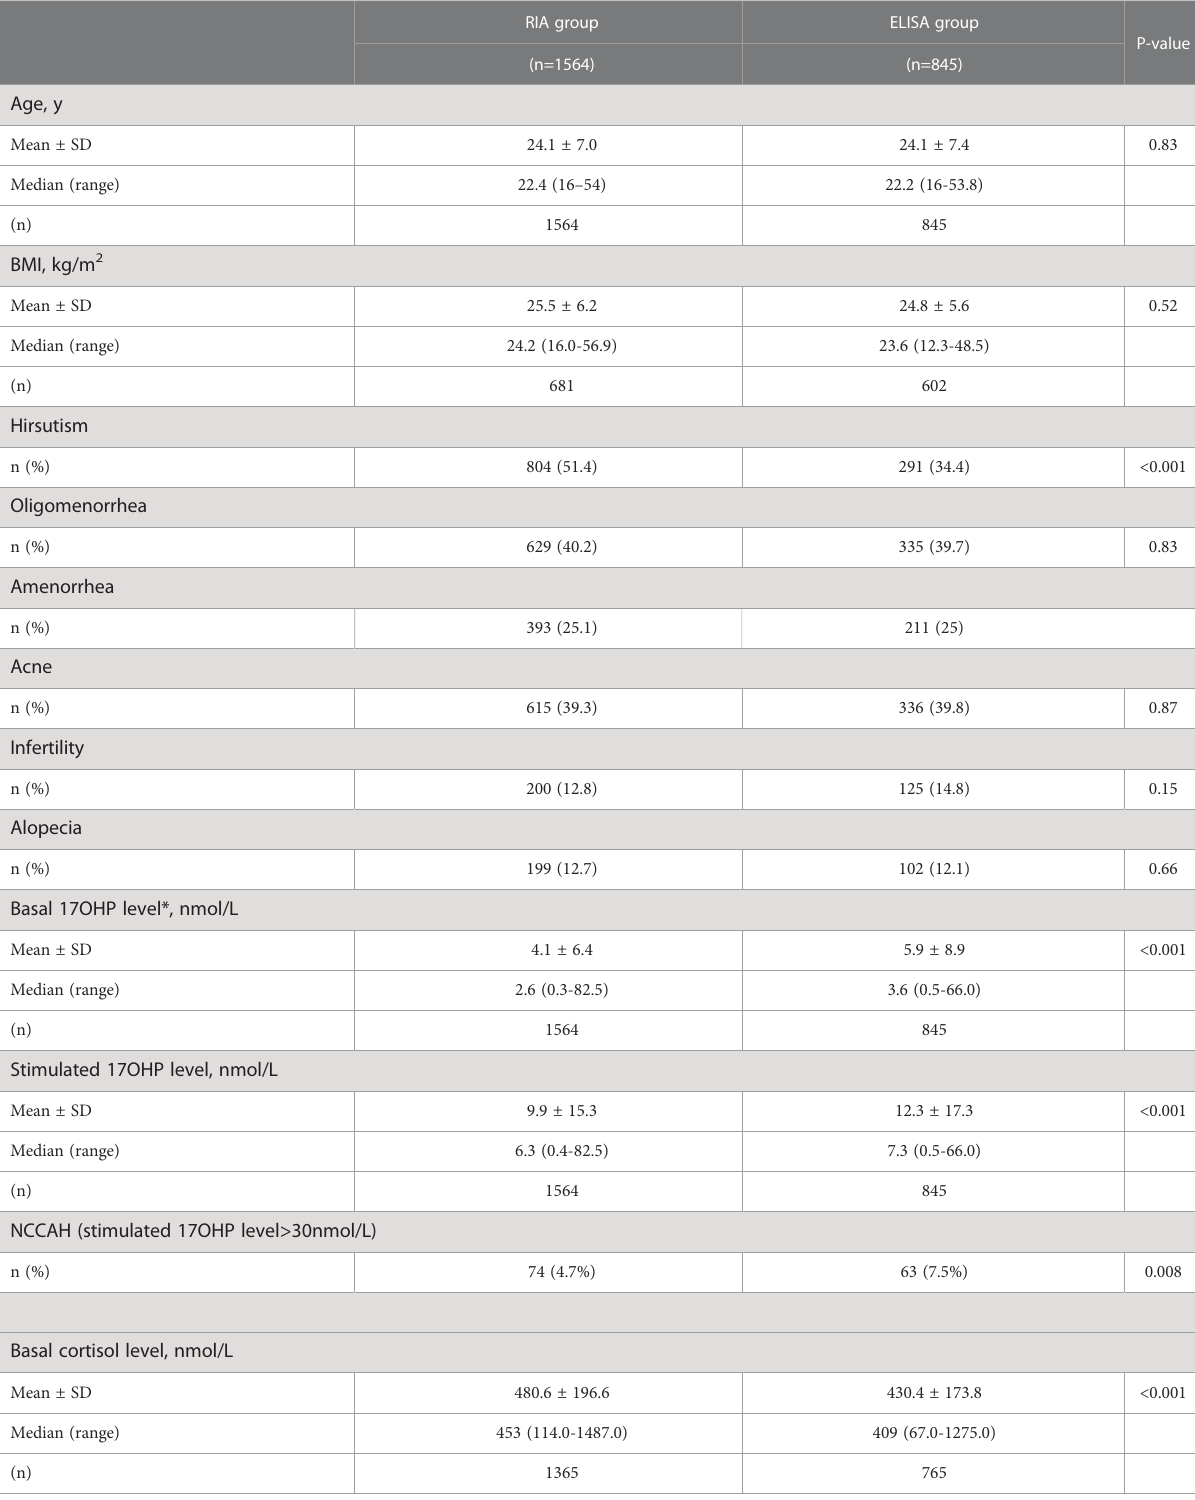
TABLE 1 Clinical and biochemical characteristics of women in the RIA and the ELISA